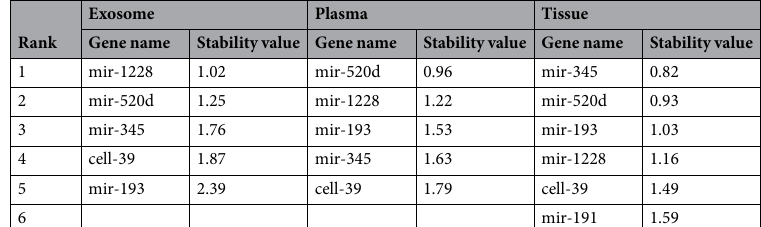
Table 4. Ranking of candidate reference miRNAs using BestKeeper algorithm.